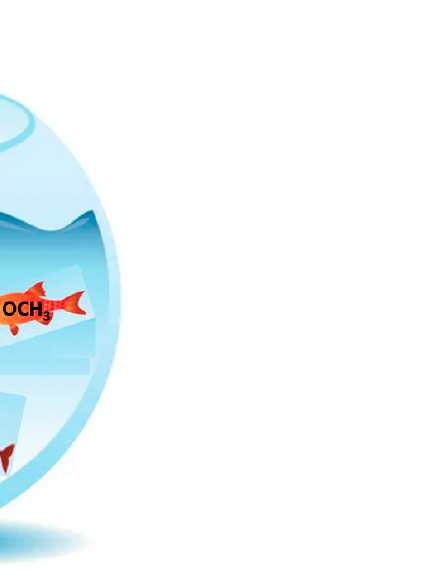
Figure 4. Graphical presentation of the idea of a “centrepiece” group ‐ contribution approach. The enthalpic contributions for these substituents can be easily derived (see Figure 5) from the differences between the enthalpy of the substituted benzene and the enthalpy of the benzene itself.